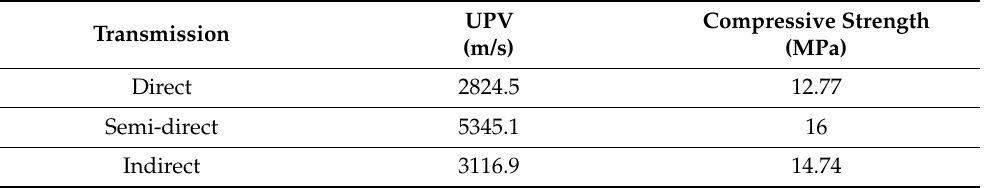
Table 3. In situ values of UPV for Umar